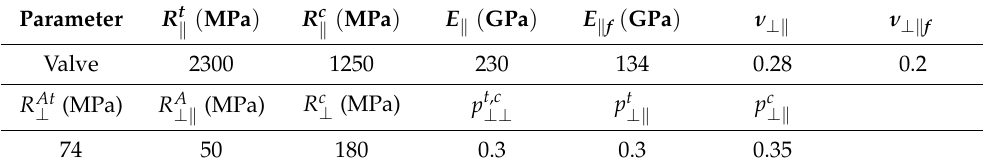
Table 6. Parameters of Puck criterion.